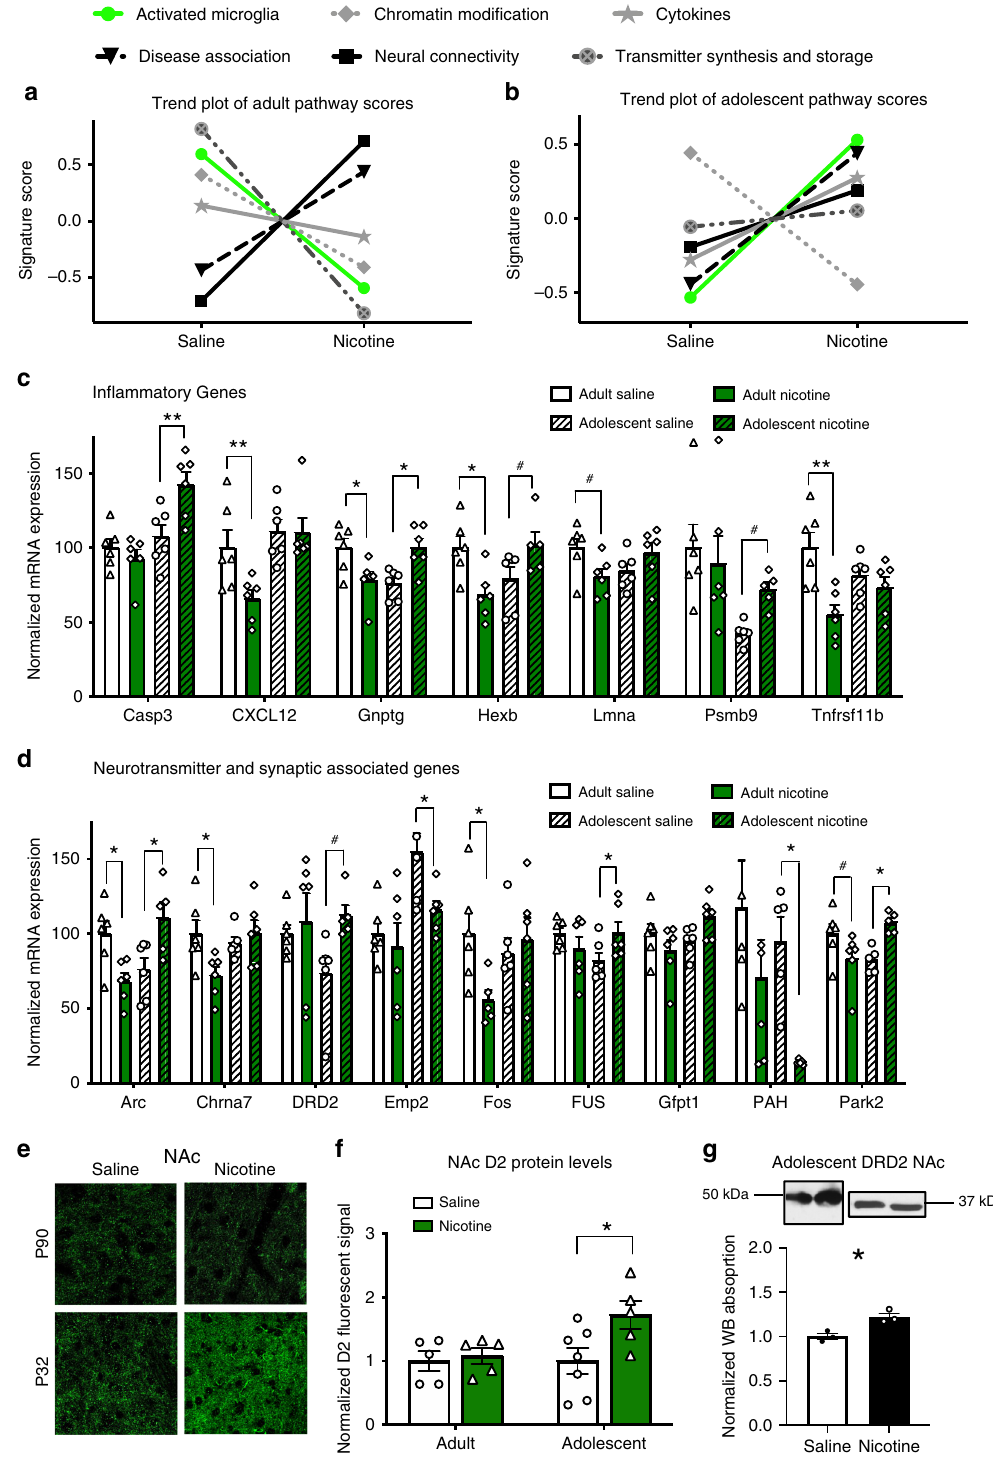
Fig. 3 Nicotine induces age-dependent differences in gene expression. a Adult nicotine exposure has distinct effects on pathway scores for associated with a variety of cellular functions. In particular, nicotine decreased overall expression of genes associated with microglial activation, which is shown as a lower activated microglia pathway score. b Adolescent-nicotine exposure increased overall expression of genes associated with microglial activation. c Analysis of speci fi c in fl ammatory genes, expressed as percentage of adult saline ( n = 6) d Analysis of speci fi c synaptic and neurotransmitter-associated genes, expressed as a percentage of adult saline ( n = 6). e Representative images of D2 receptors in the adolescent and adult NAc. f Quanti fi cation of D2 receptor fl uorescent intensity. A signi fi cant effect of nicotine ( F (1,18) = 4.598, p = 0.0459; η 2 = 16.40%; n = 5 adult, 7 adolescent-saline, 5 adolescent- nicotine) was observed. g Adolescent-nicotine exposure signi fi cantly reduced DRD2 protein levels as measured by a western blot in the NAc ( t 4 = 4.105, p = 0.0148) ( n = 3 saline, 3 nicotine). Two-way ANOVA were further analyzed with Bonferonni post hoc tests (# p < .1;* p < 0.05; ** p < 0.01). Bars show mean + /s.e.m. Source data is available as a Source Data fi